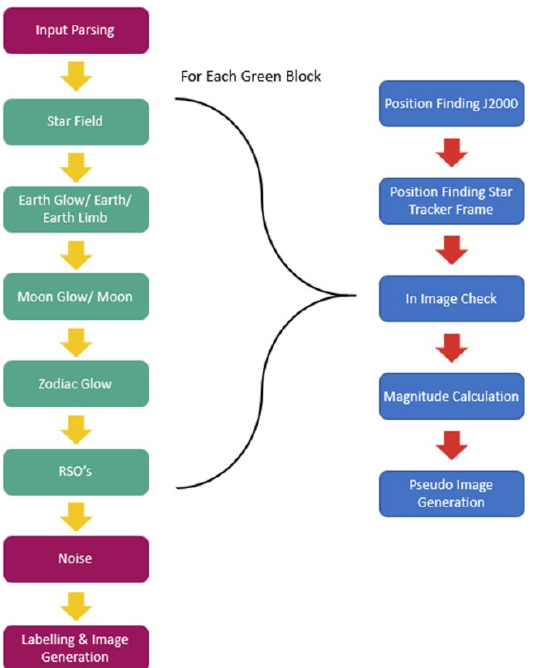
Figure 1. Space-based optical image simulator (SBIOS) system architecture is in green and purple. The image generation sequence for steps 2 through 6 are shown in blue. noisesources include: read-out noise, shot noise, and the point spread function; pseudoimage refers to the simulated image that contains the single light source, namely Earth glow, moon, zodiac glow, and RSO.